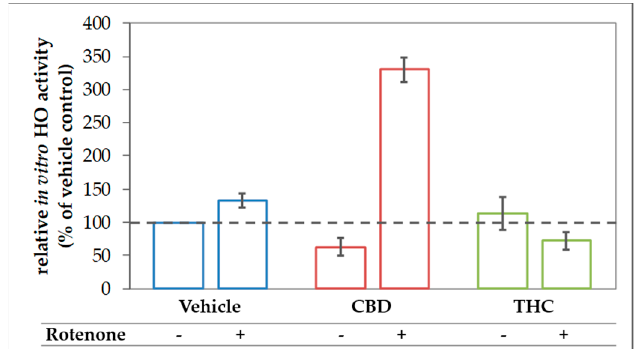
Figure 8. CBD boosts in vitro HO activity in rotenone treated N18TG2 cells. N18TG2 cells were seeded in 12-well plates and incubated with vehicle (DMSO), rotenone (80 nM), with cannabidiol (CBD; 10 µ M), or tetrahydrocannabinol (THC; 10 µ M) for 48 h. HO activity was determined as described in Material and Methods and calculated relative to the vehicle control, which was set to 100% (dashed black line). Samples were analyzed in duplicates, and the experiment was repeated twice ( n = 2). Data are shown as mean ± SD. Due to the low number of biological replicates, a statistical examination was not performed.